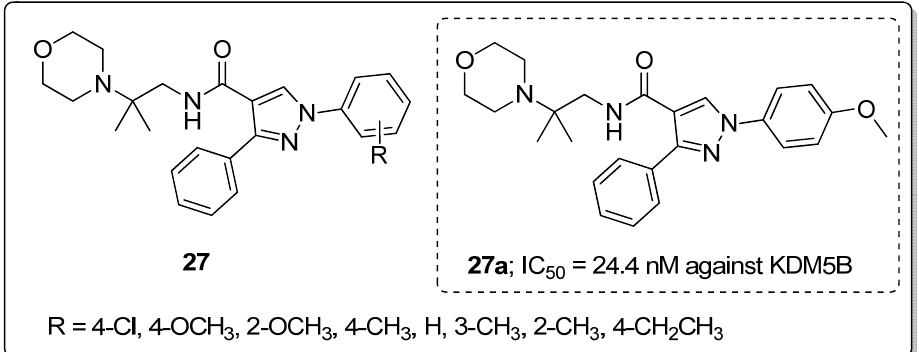
Figure 31. KDM5B inhibitory activity of the most active pyrazole conjugate 27a .